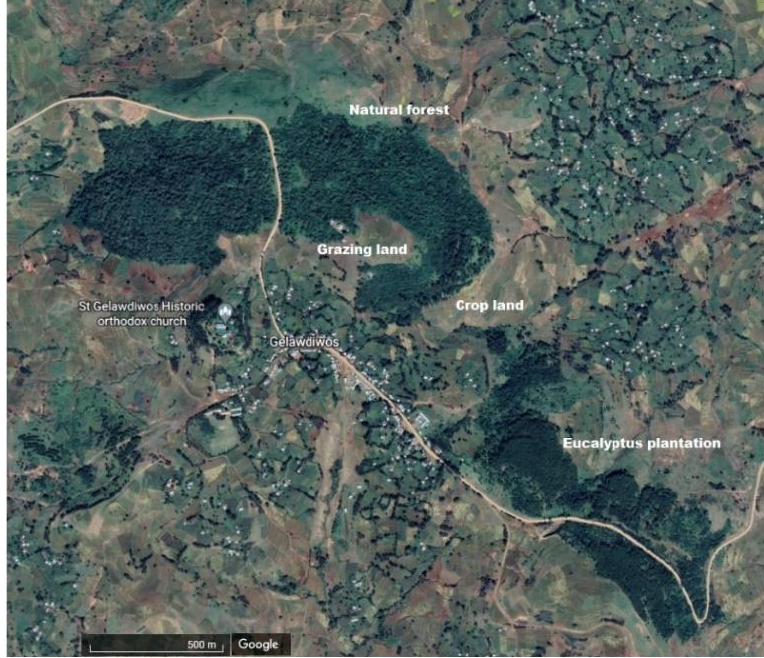
Figure A1. Map of the site at Gelawdios, Amhara, Northwestern Ethiopia (11°3 8′ 25 ″ N and 37°4 8′ 55 ″ E), showing the four adjacent land-use systems (natural forest, eucalyptus plantation, cropland, and grazing land). Based on Figure 1 of [12].